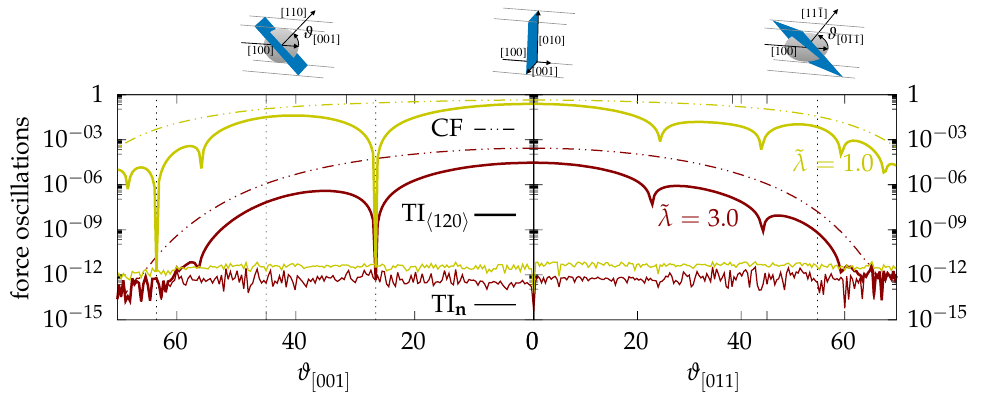
Figure 3. Logarithmic plot of the oscillation amplitude A of the total grid friction forces, i.e., the system integral over Equation (4), using the ideal profile function (3) as a function of the interface orientation angles ϑ [ 001 ] and ϑ [ 011 ] . Two different profile resolutions are compared: ˜ λ = 1.0 (yellow curves) and ˜ λ = 3.0 (red curves). The dash-dotted curves indicate the continuum field (CF) model, where no translational invariance (TI) is restored. The thick solid curves indicate the TI (cid:104) 120 (cid:105) model, which uses global grid coupling parameters (5) to restore TI for interfaces oriented normal to the (cid:104) 120 (cid:105) -directions. The TI n model (thin curves) restores TI locally in the direction of the local interface normal n . The system size is 300 × 1 ×